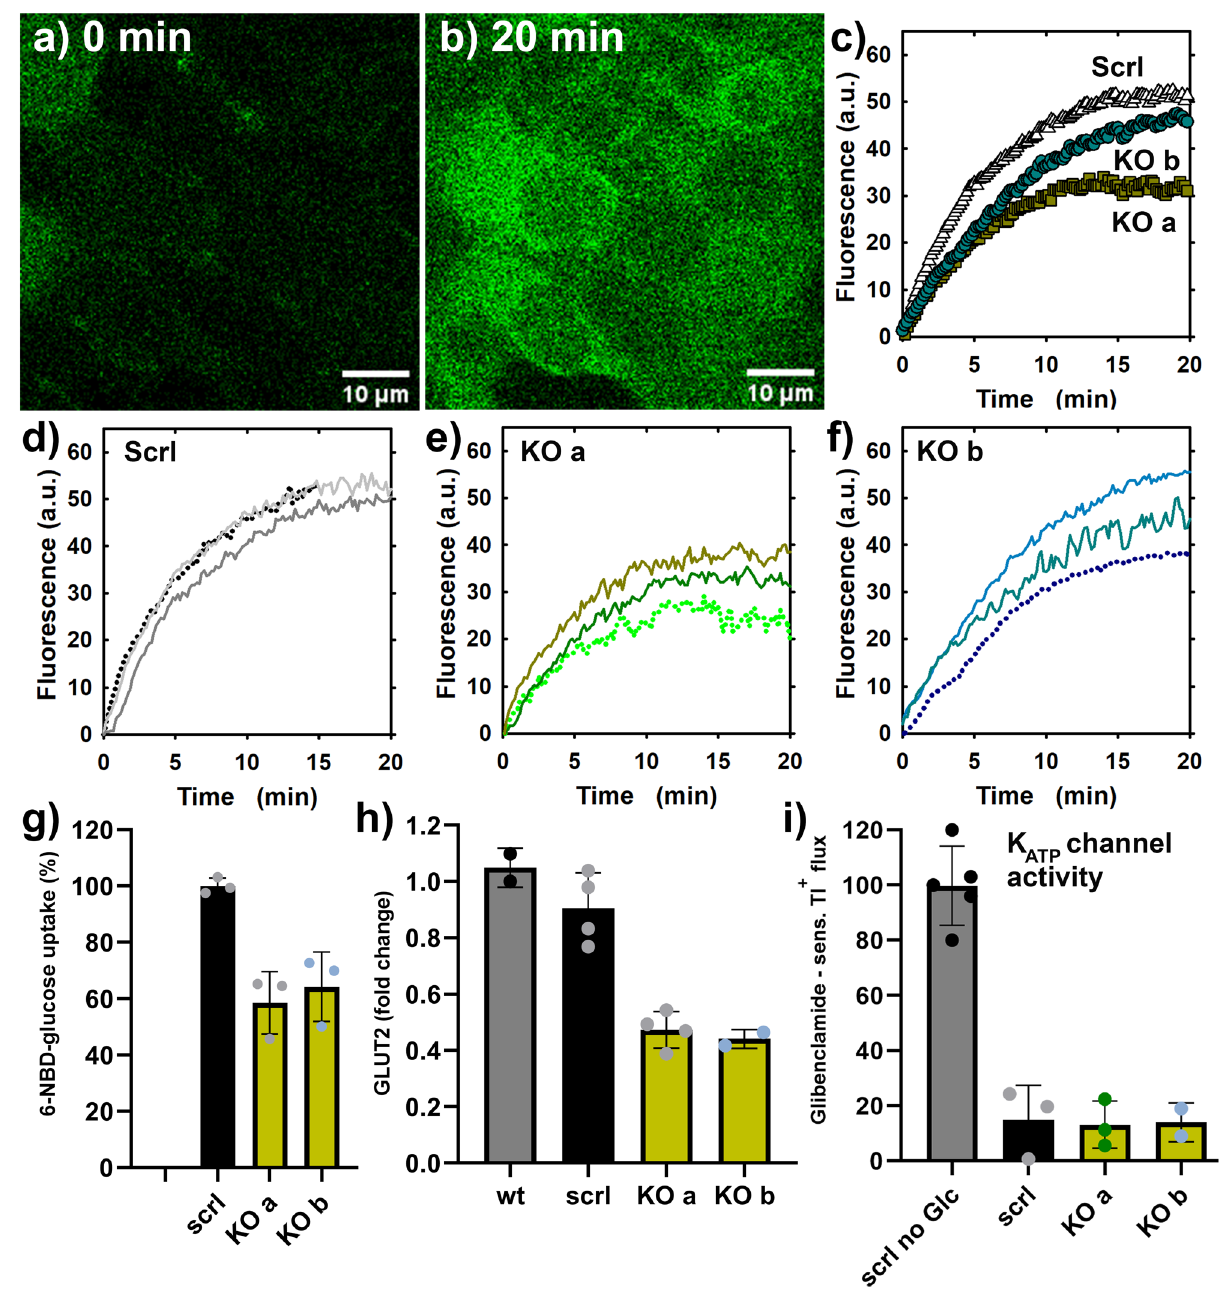
Figure 4. Glucose uptake is delayed Nkx6.1-ablated INS1E cells containing around half GLUT2, but intact K ATP channel—( b – g ) 6-(N-(7-Nitrobenz- 2-oxa-1,3-diazol-4-yl)amino)-6-d eoxyglucose (6-NBDG) uptake into cells assessed in a confocal microscope; ( h ) relative transcripts rates of GLUT2; ( i ) Responses of Tl + fluxes to glucose as surrogate for K + fluxes, to which a K ATP is a major contributor. Panels ( a , b ) shows confocal images at time zero ( a ), when wt INS-1E cells are dark and the just added 100 μM 6-NBDG causes a fluorescence background around cells; and 20 min after ( b ), when cells are filled with 6-NBDG. ( c ) Compares time-courses averaged from individual time courses, displayed on panels ( d – f ). Basal rates were already subtracted, i.e. those when the GLUT2 inhibitor (100 μM BAY-876) blocked the 6-NBDG uptake by up to ~ 95%. ( g ) Shows statistics of initial rates of the 6-NBDG uptake. ( h ) Shows relative Glut 2 transcripts amounts. ( i ) Indicates no closure of K ATP channels in the absence of glucose (Tl + influx rate is normalized to 100%) and equal glucose-stimulated closure of K ATP channels independent of the Nkx6.1